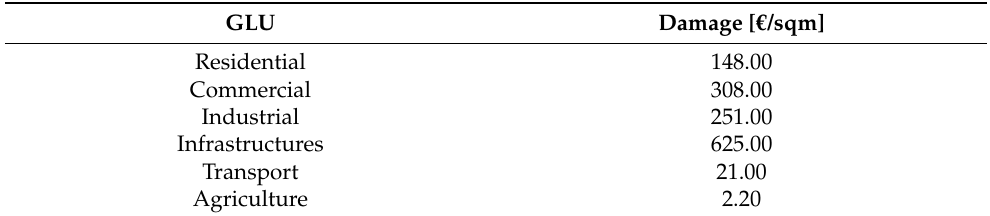
Table 6. Potential economic damage measured in euros per square meter in relation to GLU classes, based on [43].